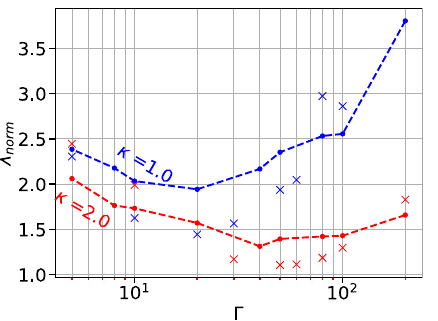
2 (cid:31) / nk β ω p a ws =